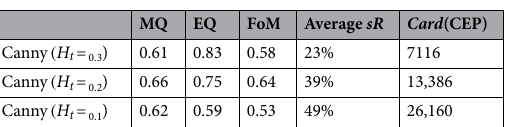
MQ EQ FoM Average sR Card